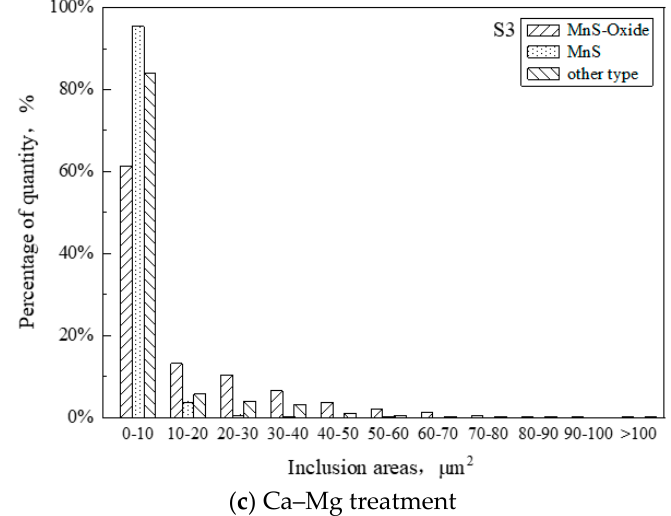
Figure 7. Area distribution of inclusions in rolled steel samples.